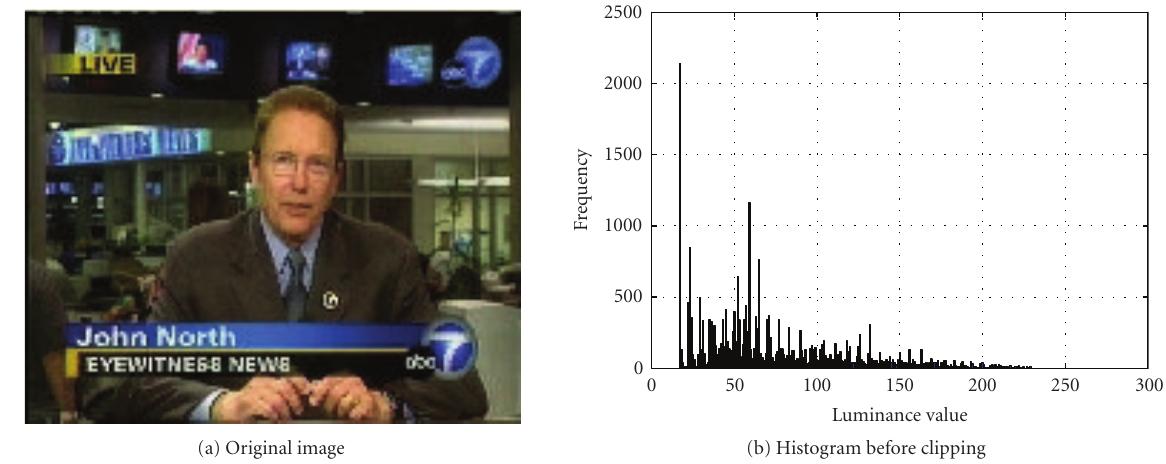
Figure 3: Image and its luminance histogram before clipping.